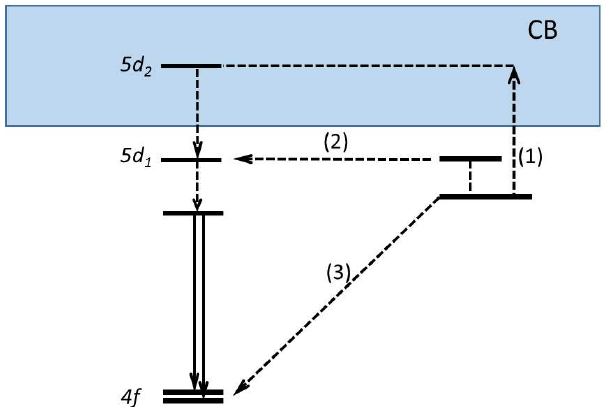
Figure 14. Schematic energy level diagram for the possible recombination pathways of trapped electrons in GAGG:Ce crystal: (1) thermally stimulated non-localized transition (classical TSL), (2) thermally assisted tunnelling, and (3) ground state tunnelling recombination. CB = Conduction Band (Adopted from [107]).